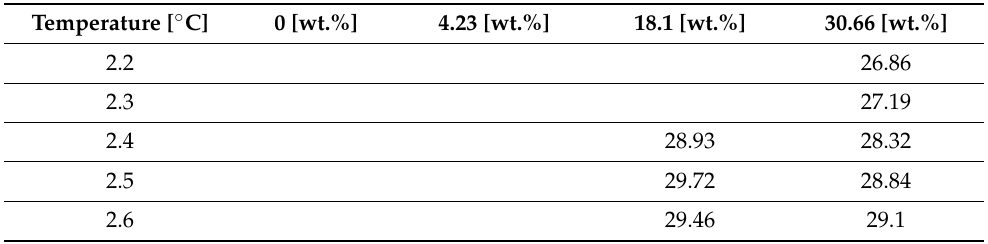
Table 2. Equilibrium values for methane hydrate in the presence of CuSn12 powder, analyzed with four different